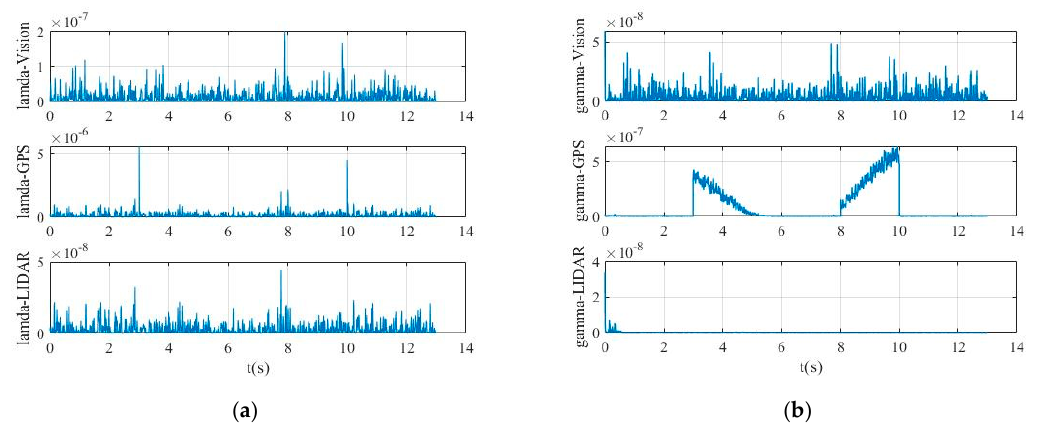
Figure 7. The changes of fault detection function for yaw angles in simulation based on: ( a ) double state chi-square detector; and ( b ) residuals chi-square detector.